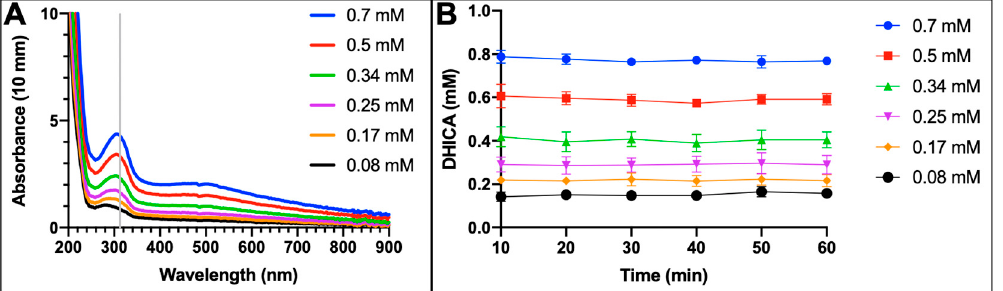
Figure 5. TYRP2 is enzymatically active. ( A ) In the dopachrome tautomerase reaction, TYRP2 incubated with isolated native dopachrome for 30 min causes an increase in the DHICA absorbance at 315 nm (noted with the gray bar). Increasing concentrations of dopachrome from 0.08–0.7 mM were used. ( B ) The concentration of DHICA increases with increasing concentrations of substrate used but remains constant over the 1 h reaction.